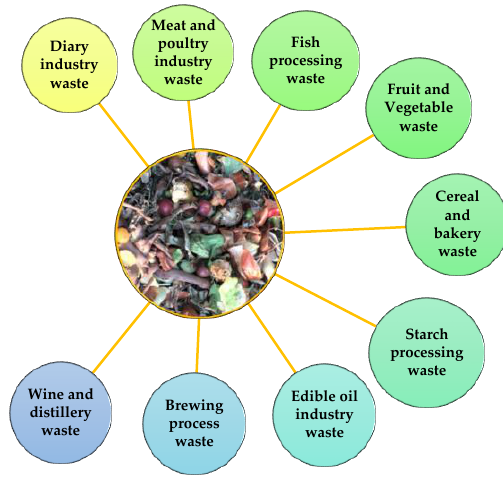
Figure 5. Categories of food waste.